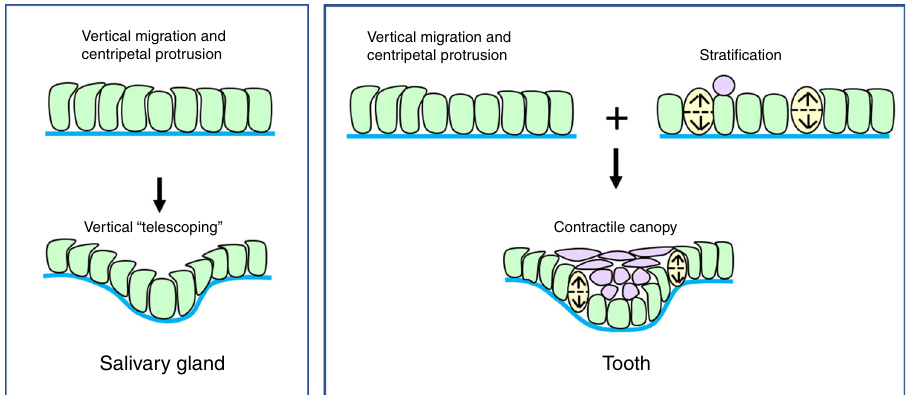
Fig. 5 Tooth morphogenesis is a composite of vertical telescoping plus canopy contraction. Schematic of epithelial invagination in the SG and molar, respectively by VT alone or a simple combination of VT, vertical cell division, and canopy contraction by suprabasal cell intercalation. Blue line: basal lamina. Green: basal cells. Yellow: dividing cells. Lilac: